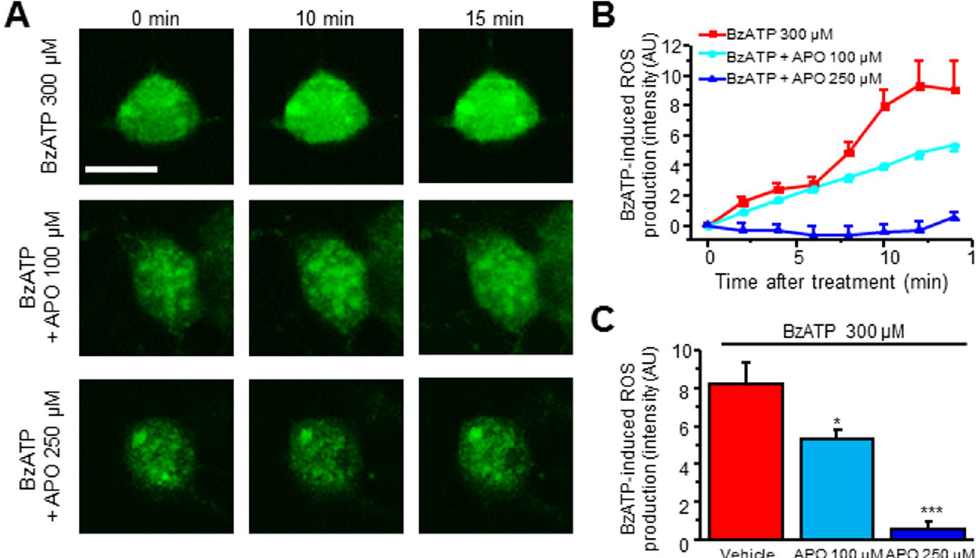
Figure 3. NOX inhibition attenuates BzATP-mediated ROS production. ( A ) Representative of live cell confocal images captured before (0 min) and after application of BzATP in the presence of vehicle or apocynin (100 µ M, 250 µ M). ( B ) Time lapse of ROS production after BzATP (300 μ M) administration in the presence of vehicle or apocynin. ( C ) Summary of the effects of apocynin on BzATP-induced ROS production. Values represent mean ± SEM, n = 6–12 neurons. * P < 0.05, *** P < 0.001 compared to BzATP group by the one-way ANOVA. Scale bar 10 µ m.